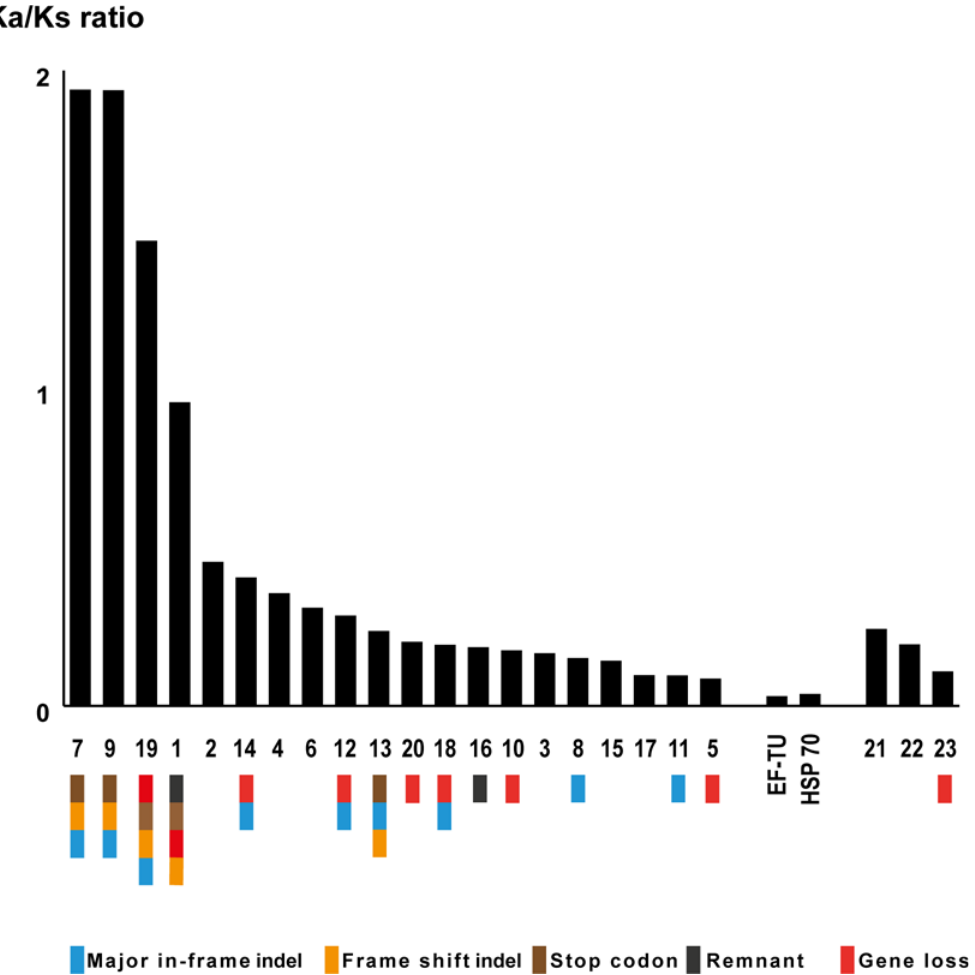
Fig 2. Average K a /K s ratios between the LGTs. The average K a /K s ratios for each of the LGTs and reference genes between strains. The numbers under the bars in represent the LGTs as listed in Fig 1A. The boxes under the bars shows the fate of the corresponding LGT in genus Leishmania – classified as gene acquisition, degradation, acquirement of stop codons and indels respectively. Four LGTs (LmjF.03.0390, LmjF.15.0740, LmjF.23.0260 and LmjF.36.0260) have K a /K s ratios (cid:3) 1, and these LGTs have frame shift- and major in-frame indels, and contain stop